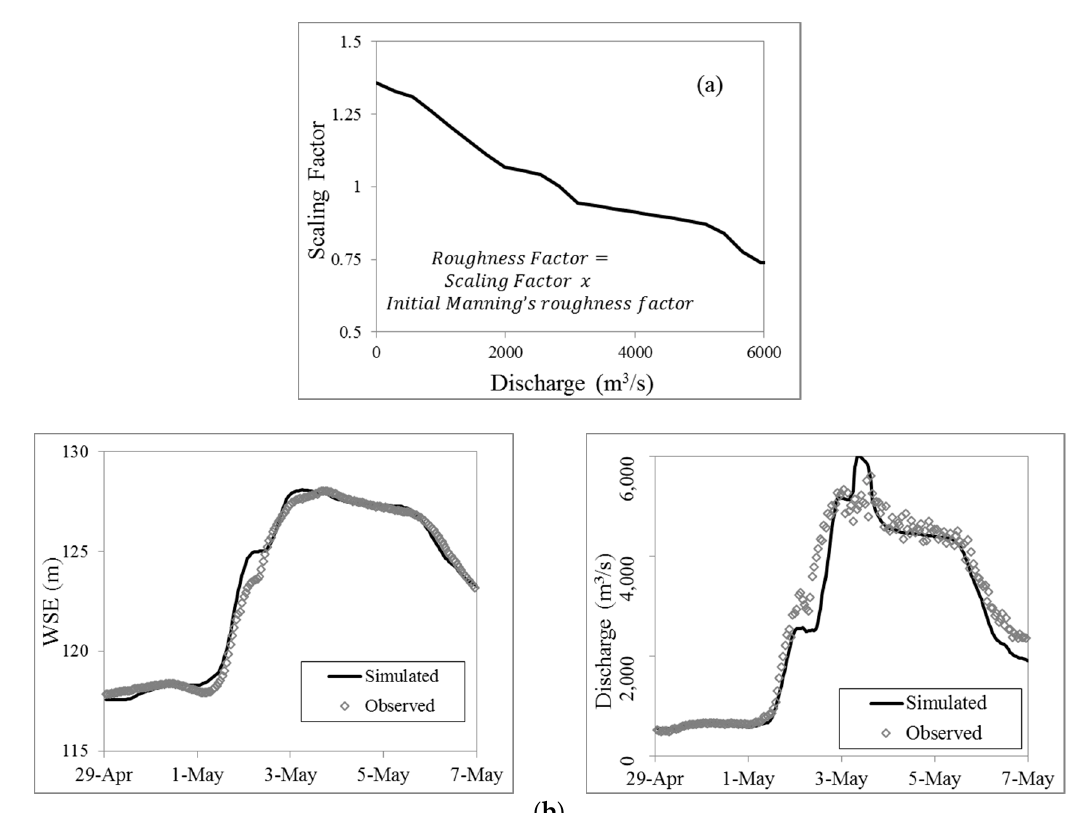
Figure 5. ( a ) Factors to scale the initial Manning’s roughness factors; ( b ) Calibration plots for WSE and discharge near Nashville.